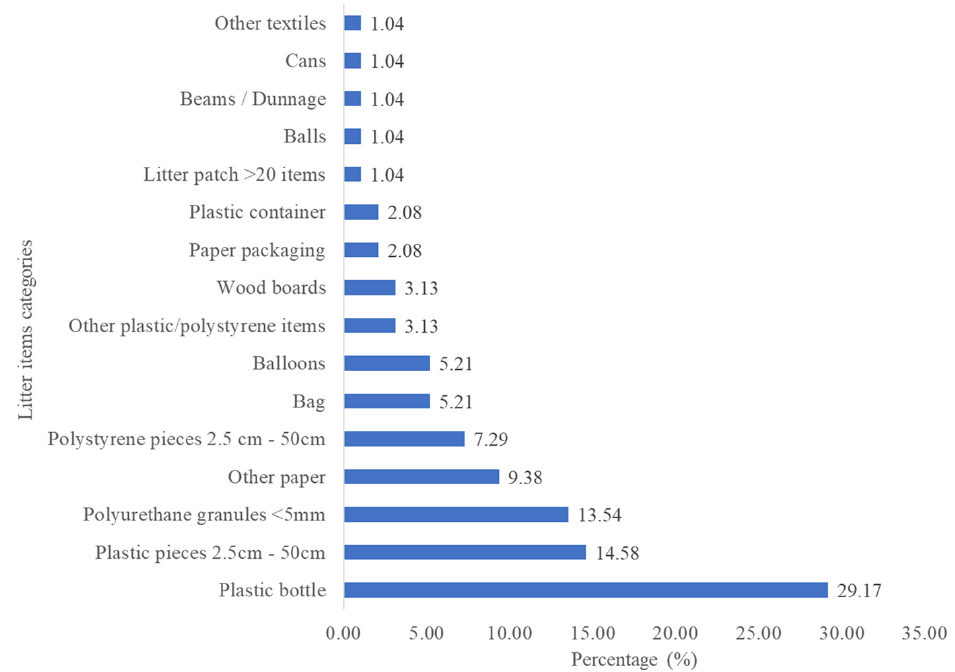
Figure 7. Percentage of recorded litter item categories at the Matsesta River.